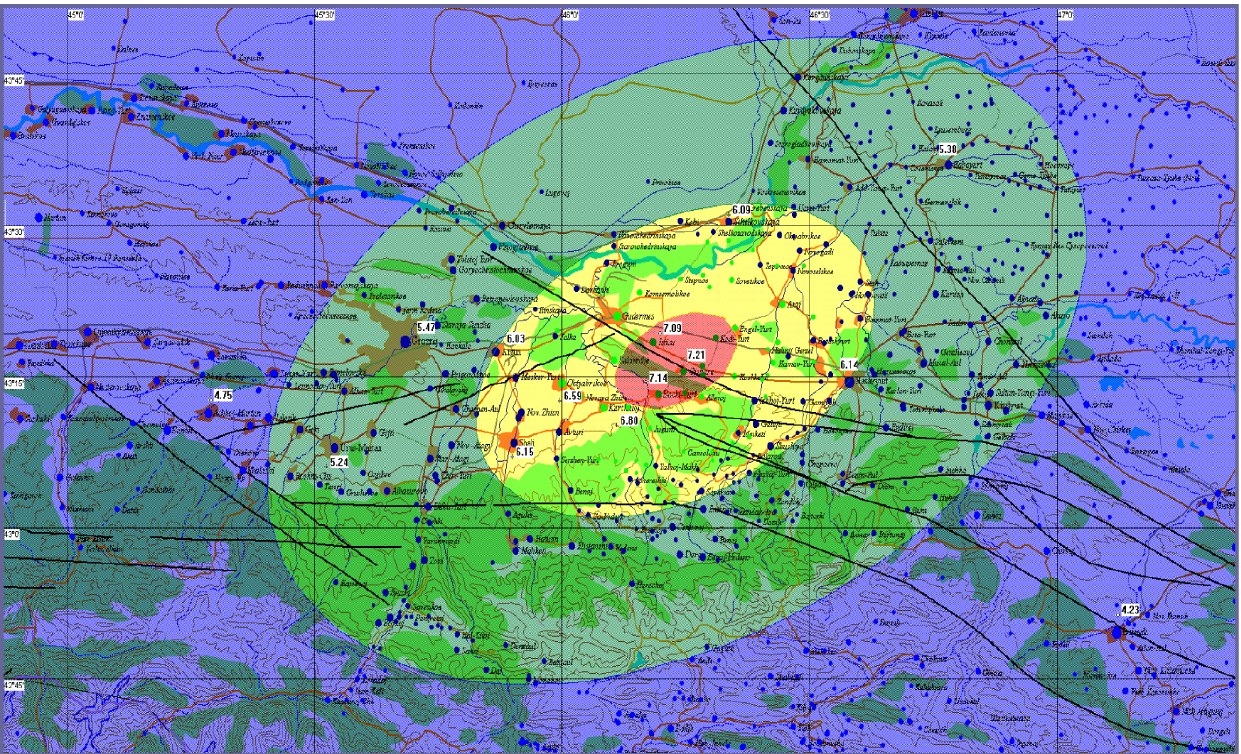
Figure 5. Calibrated model application for simulation of the 2008 Kurchaloy earthquake consequences; map based on layers from the Digital Chart of the World